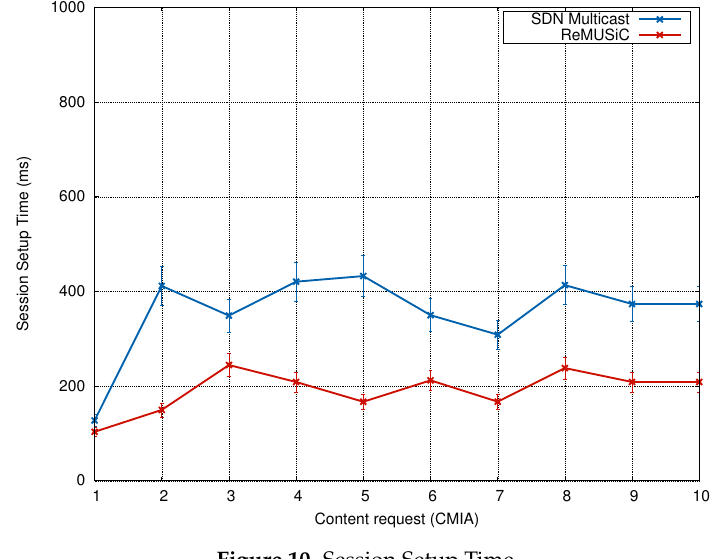
Figure 10. Session Setup